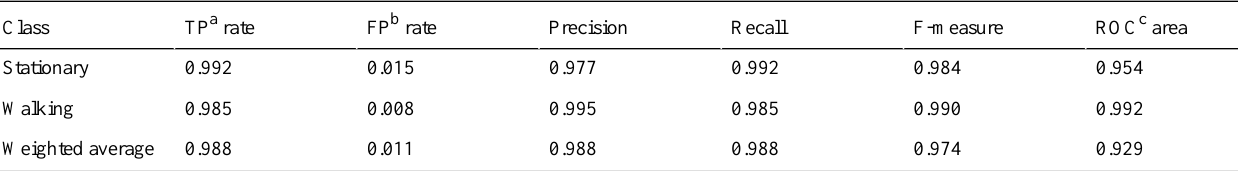
Table 1. Online watch